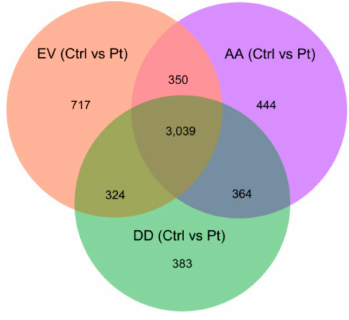
Figure 5. Venn diagram representing the exclusively and commonly regulated genes in di ff erent transfected cells upon cisplatin exposure. The diagram shows the total number of genes a ff ected by cisplatin exposure in empty vector—(EV), PEA-15AA—(AA) and PEA-15DD-transfected—(DD)